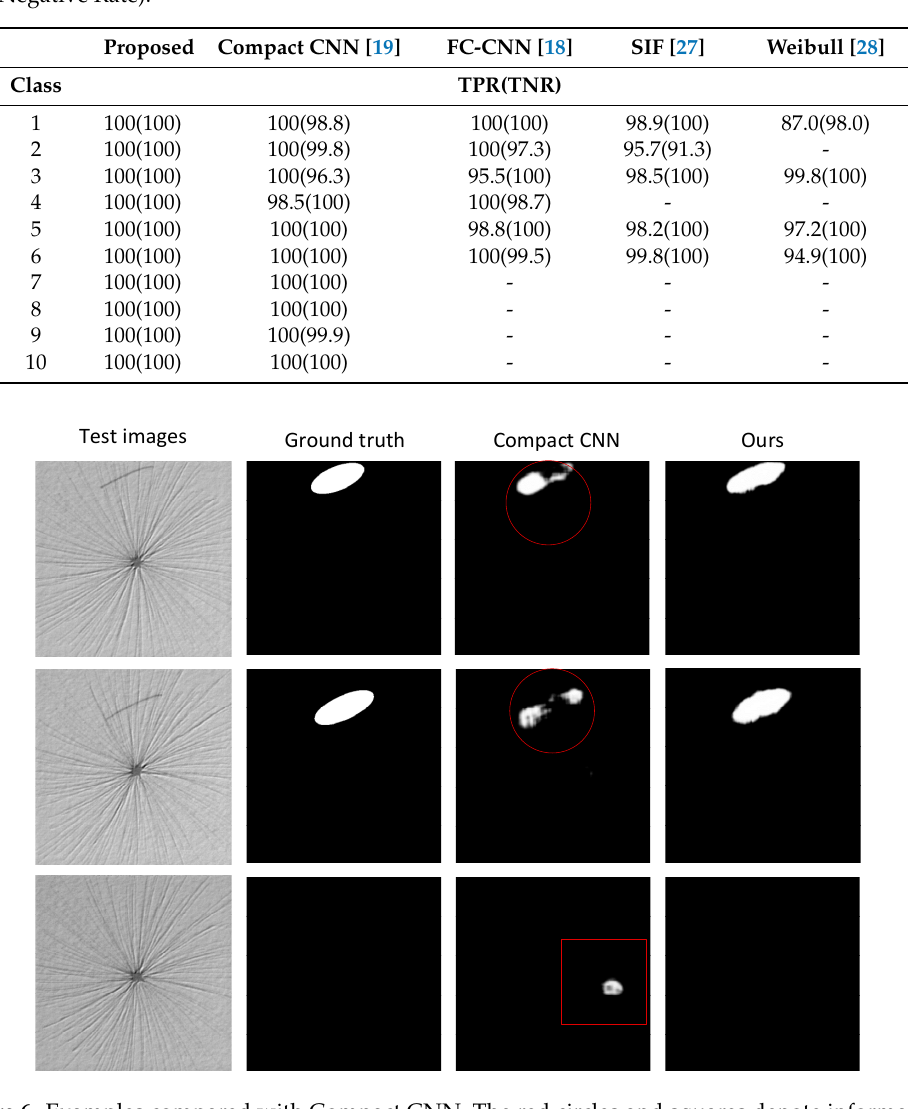
Table 3. Classification performance of the proposed model vs. others (TPR: True Positive Rate; TNR: True Negative Rate).